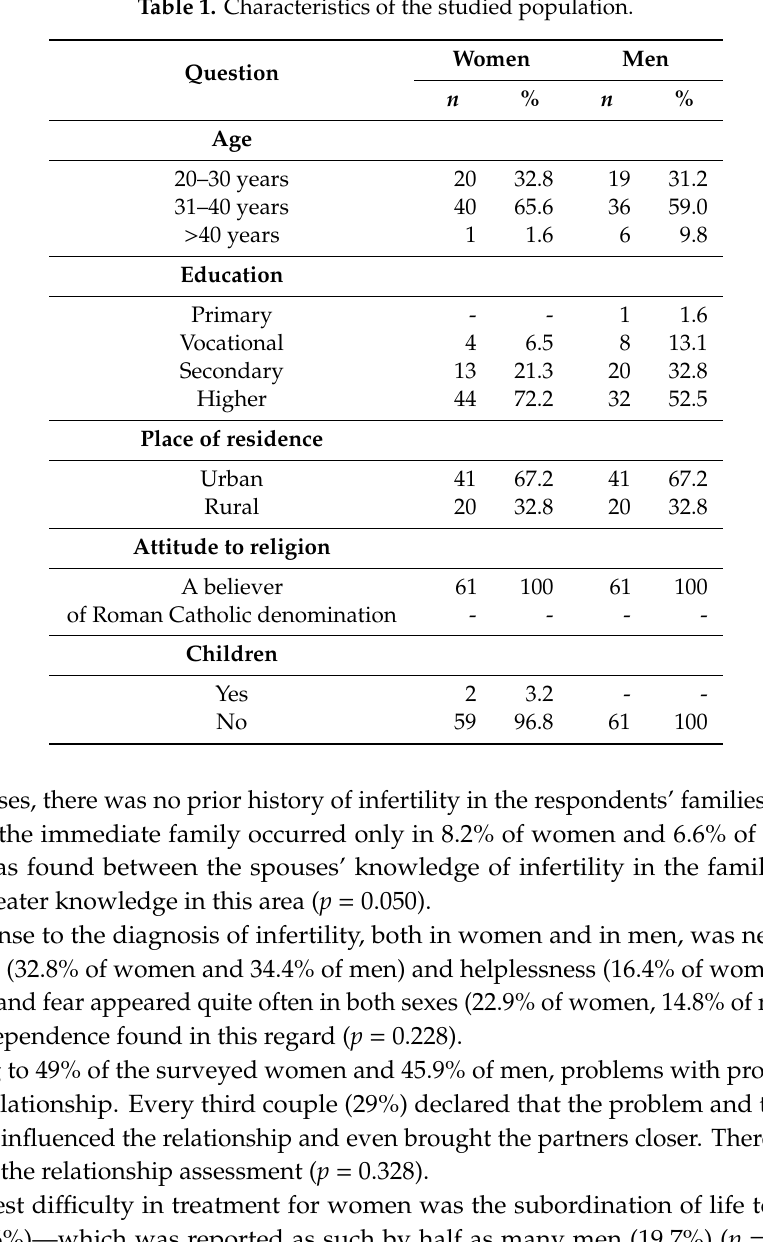
Table 1. Characteristics of the studied